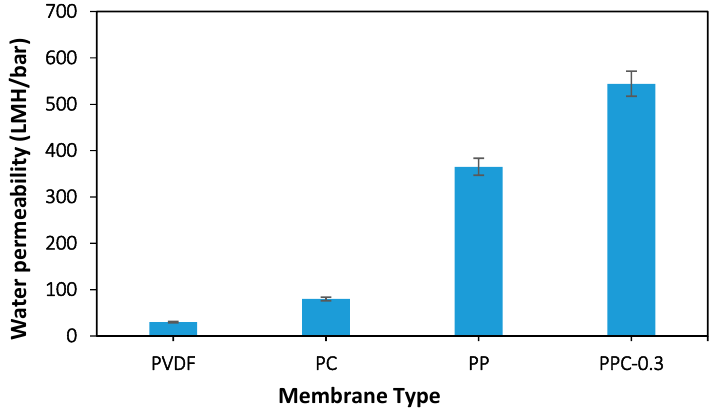
Figure 9. Water permeability for pristine and different types of membrane fabricated .